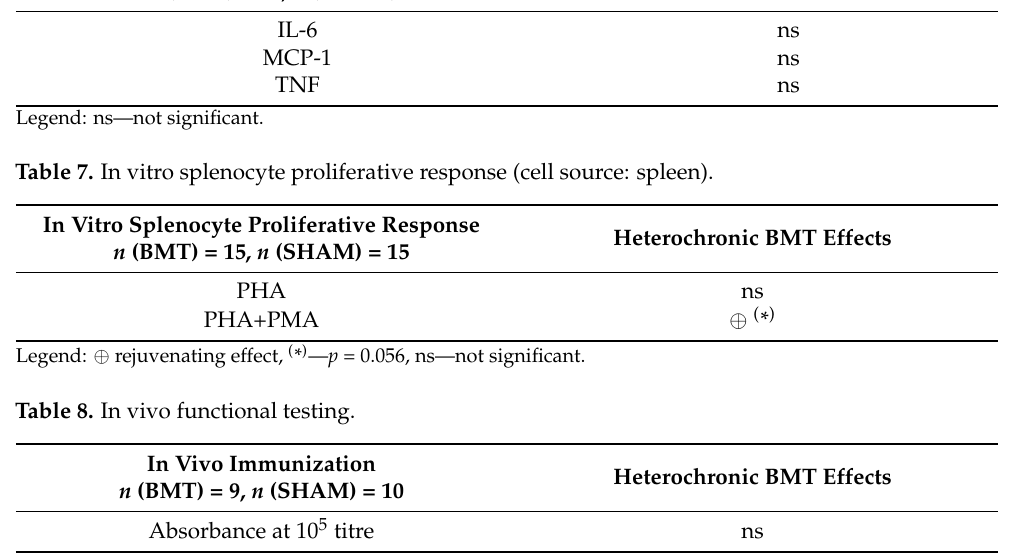
Table 6. In vitro cytokine release assay (cell source: peritoneal cavity).4285. In Vitro Cytokine Release Assay, Peritoneal Cells